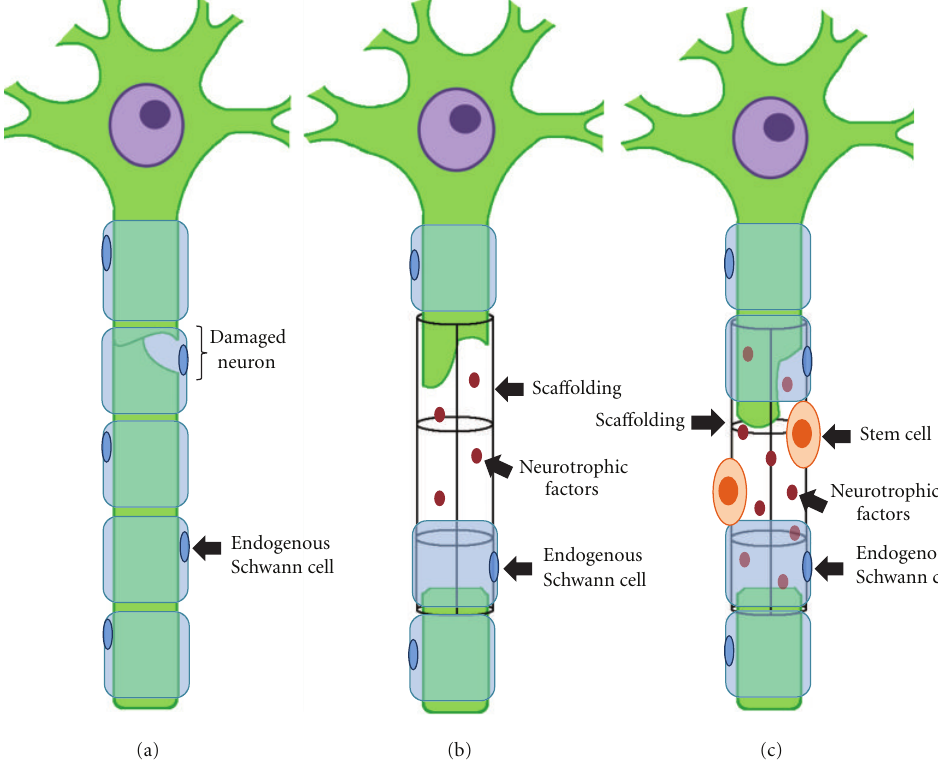
Figure 1: Stem cell with sca ff old support in peripheral nerve injury. (a) Nerve injury with stem cell transplantation shows limited remyelination and axonal growth between the proximal and distal stumps. (b) Nerve injury with sca ff olding devices can be fabricated to secrete neurotrophic factors aiming to enhance the regenerative process, but still the outcome results in limited remyelination and axonal growth between the proximal and distal stumps. (c) The combined use of stem cells and sca ff olding promotes best results, allowing an improved substrate for cell-to-cell contact and increased concentrations of released neurotrophic factors. Additionally, transplanted stem cells may stimulate endogenous Schwann cells to proliferate at a higher rate, thus enhancing remyelination and axonal growth following peripheral nerve